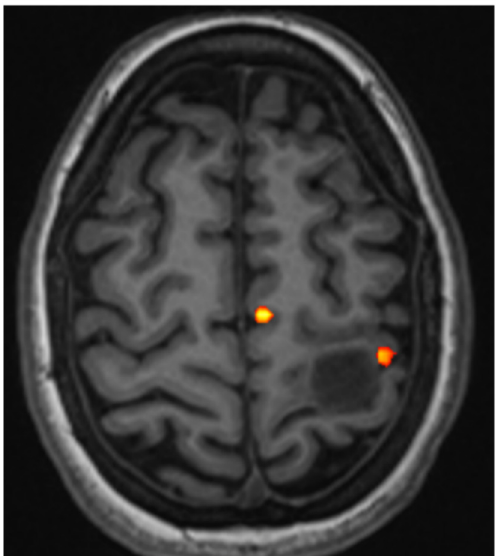
Figure 3. An exemplary fMRI of a patient with a left frontal lobe mass at the precentral gyrus (hand knob area) showing lateral displacement of the parenchymal associated with hand activation. Additional activation in the medial cerebral cortex of the left paracentral sulcus just anterior to the left paracentral lobule represents the supplementary motor area (SMA).